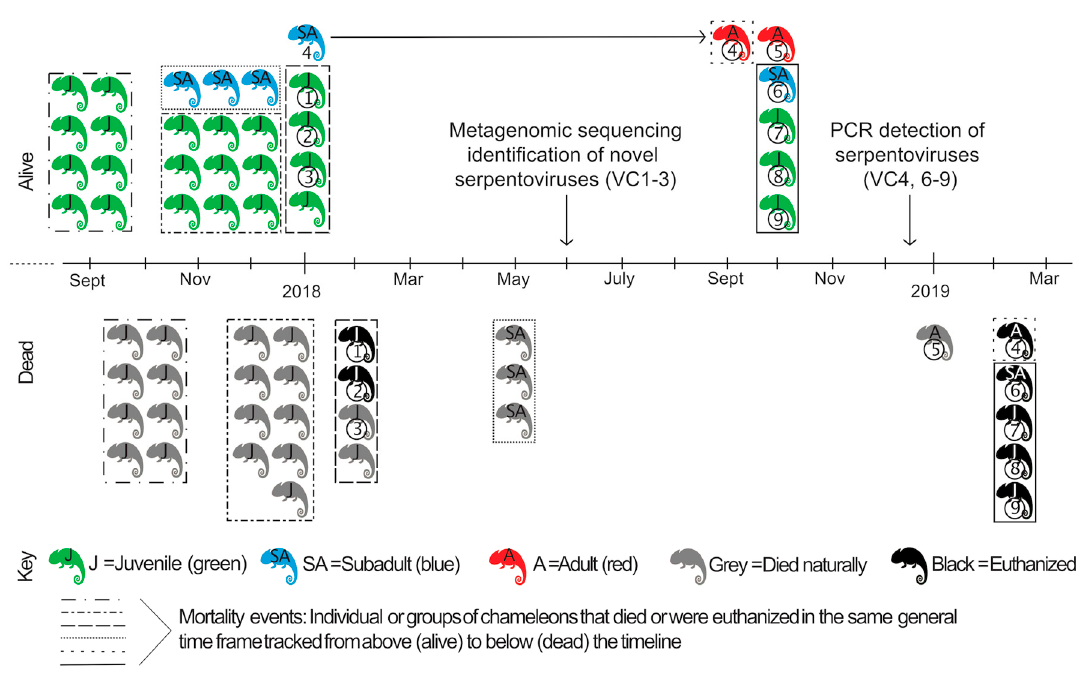
Figure 1. Timeline of case history. A schematic depicting the introduction and death of chameleons into the study collection. Purchased chameleons entering the collection are represented above the timeline (alive). Those same chameleons are represented below the timeline (dead) following euthanasia or natural death; all deaths were associated with clinical signs of respiratory disease except possibly VC5. Individual or mass mortality events are indicated by dashed and dotted lines encircling groups of chameleons. The same border pattern can be found around chameleons above and below the timeline correlating with the groups entry into the collection and then similarly timed deaths. VC4 survived to the age of an adult; progression from subadult to adult is indicated by the horizontal arrow linking the two VC4 symbols. Chameleons that were tested for viral infection (VC1–9) are indicated by the circled identification number directly below the chameleon icon.